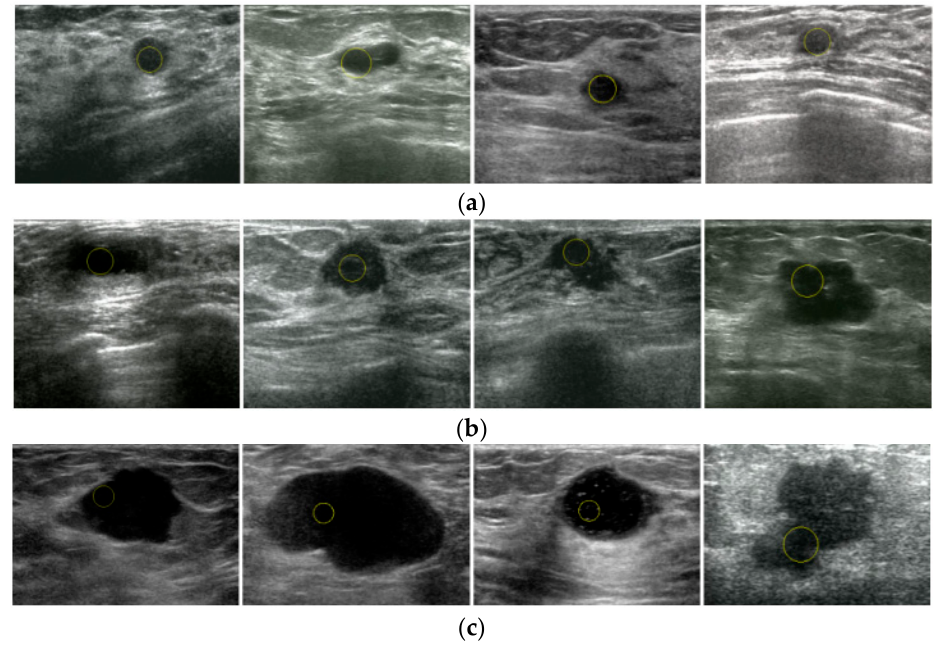
Figure 11. Localization results of 12 US breast images by the proposed method: ( a ) small tumors, ( b ) tumors of medium sizes, ( c ) tumors with pretty large sizes.